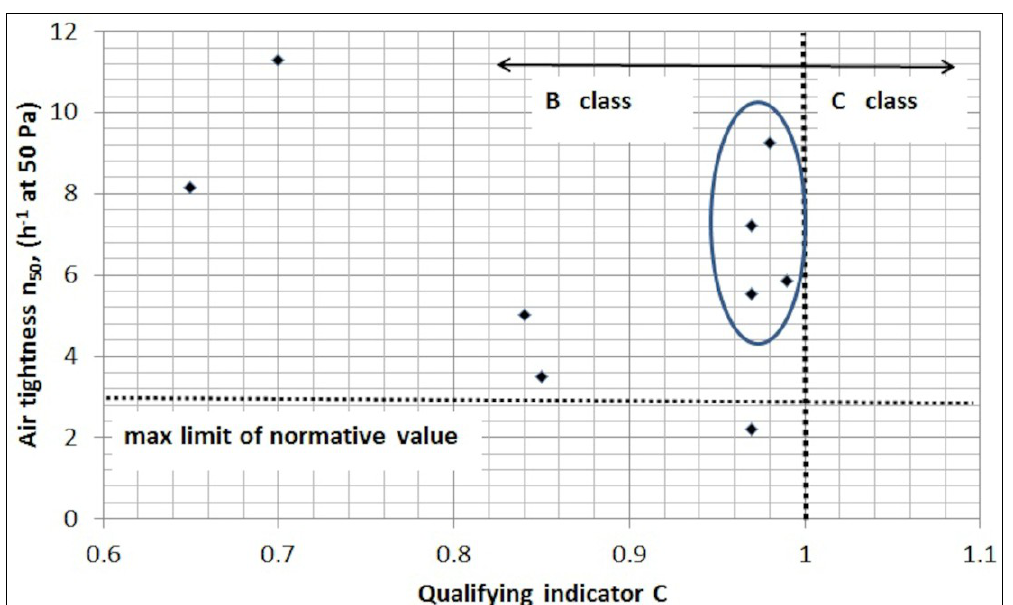
Figure 5. The rankings of B energy efficiency class buildings according to the qualifying indicator C